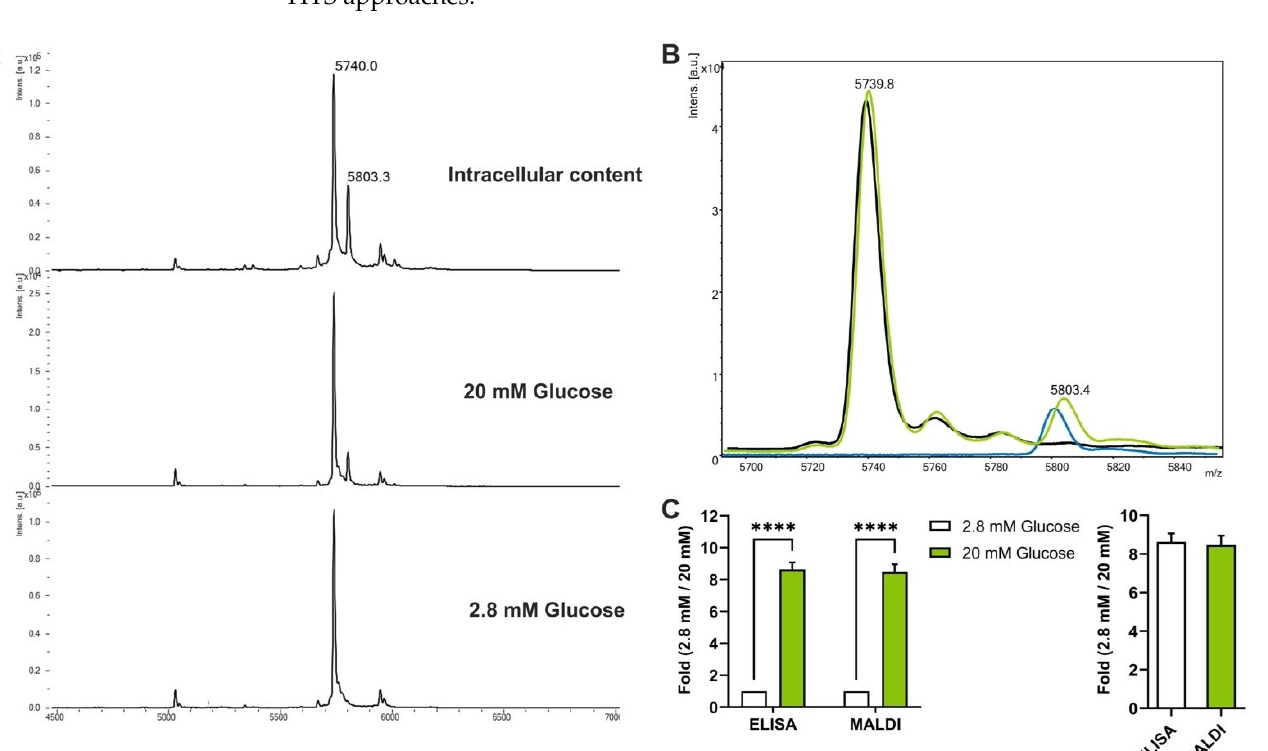
Figure 2. Measurement of insulin secretion from Min6 cells through MALDI-TOF mass spectrometry. ( A ) Mass spectra of the intracellular insulin content, 20 mM and 2.8 mM of glucose secretomes; ( B ) Superposition of the different mass spectra of murine and bovine insulin (black: bovine, blue: murine, green: mixture); ( C ) Quantification of insulin secretion after stimulation with glucose by MALDI-TOF mass spectrometry. Min6 cells were cultured in a 384-well plate and then subjected to automated GSIS and insulin secretion was measured comparing ELISA (n = 4) and MALDI-TOF (n = 16) as detection methods. Samples from two independent plates were analyzed. Statistical analyses were performed using two-way ANOVA with Bonferroni post-test analyses. Results are presented as means ± SEM. **** p < 0.0001.